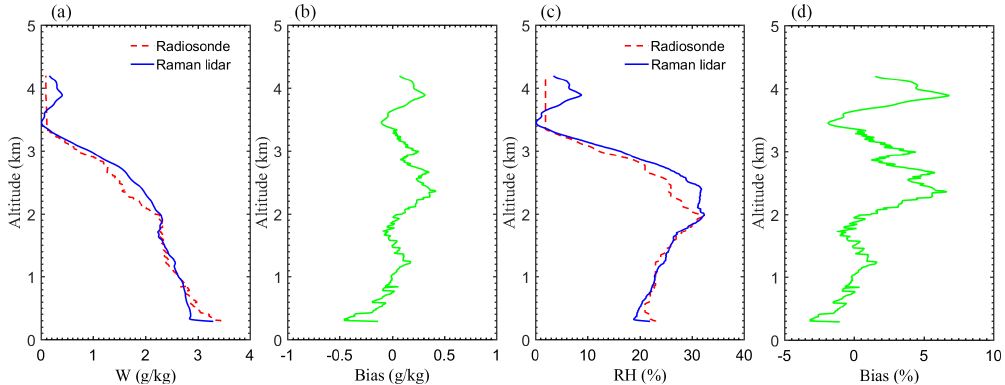
Figure 1. (a, c) Water vapor mixing ratio ( W ) and relative humidity (RH) profiles at 05:15CST 24 May 2016 retrieved by the Raman lidar (blue line) and the radiosonde (red dashed line), respectively, and (b, d) the absolute error in W and RH between the lidar and radiosonde retrievals (lidar minus radiosonde), respectively.